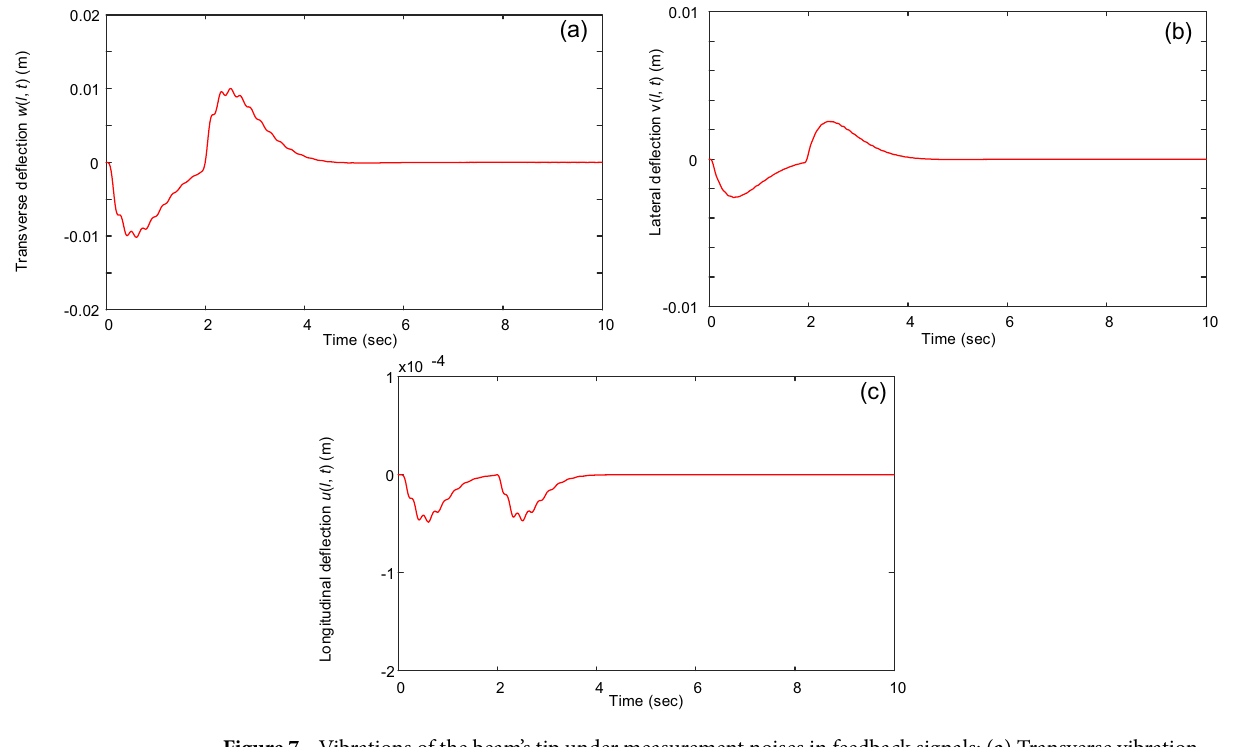
Figure 7. Vibrations of the beam’s tip under measurement noises in feedback signals: ( a ) Transverse vibration w ( l , t ), ( b ) lateral vibration v ( l , t ), and ( c ) longitudinal vibration u ( l , t